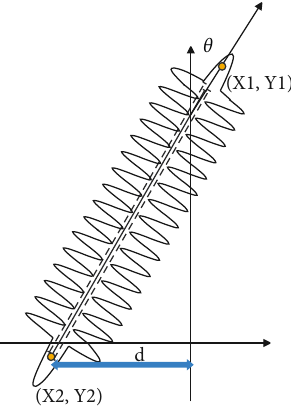
Figure 5: Geometric analysis of image ray reflection angle calculation.